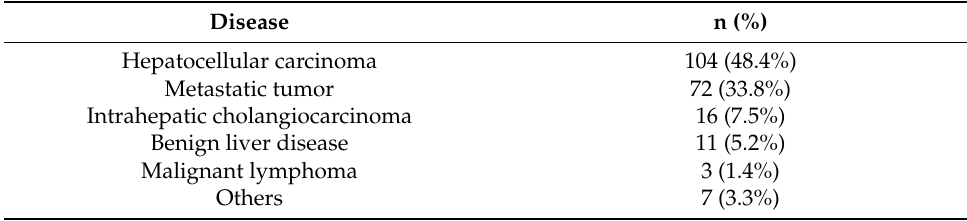
Table 1. Indications of 213 MIALR cases.